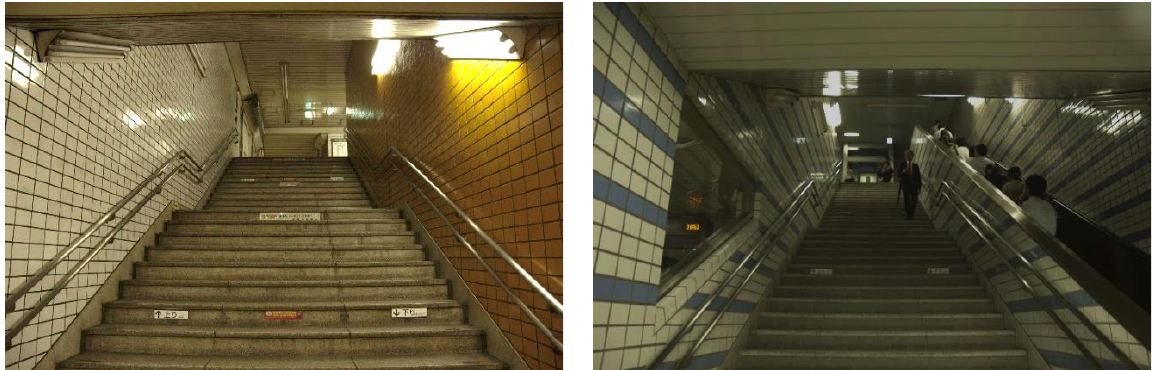
Figure 18. Front views of the No. 11 ( left ) and No. 20 ( right ) platforms.